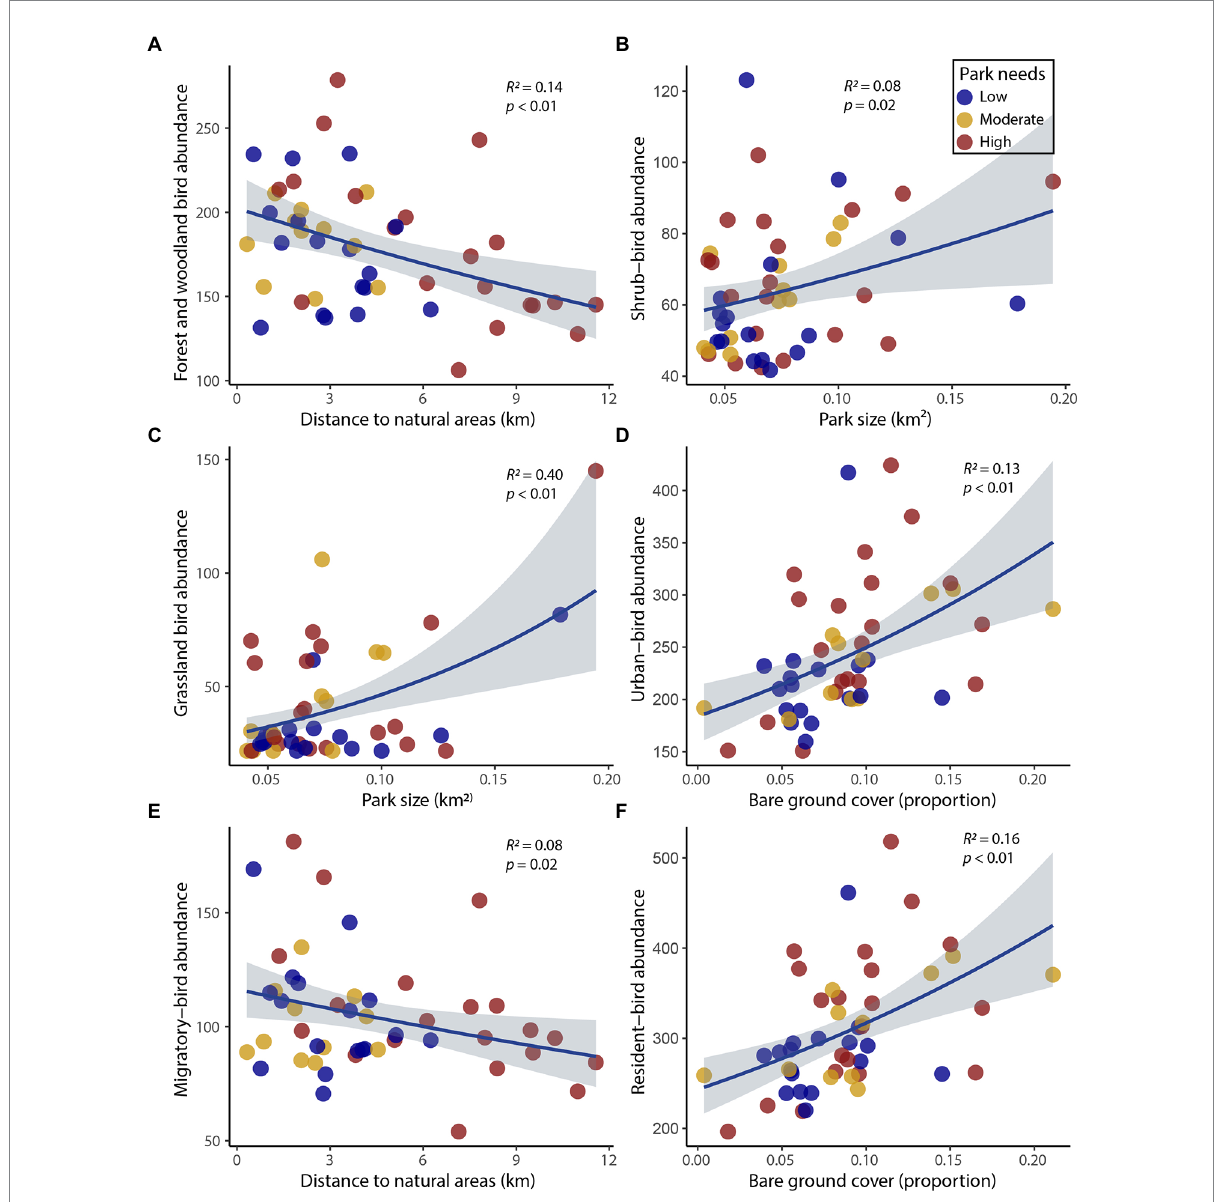
FIGURE 5 Scatterplots depicting the relationships of the top models for (A) forest and woodland, (B) shrub, (C) grassland, (D) urban, (E) migratory, and (F) resident bird abundance with independent variables. We generated the fitted line and confidence interval (gray shading) based on a negative binomial generalized linear model analysis. The R 2 values are Kullback–Leibler-divergence-based 2 R likelihood ratio index of a fitted model (Cameron and Windmeijer,